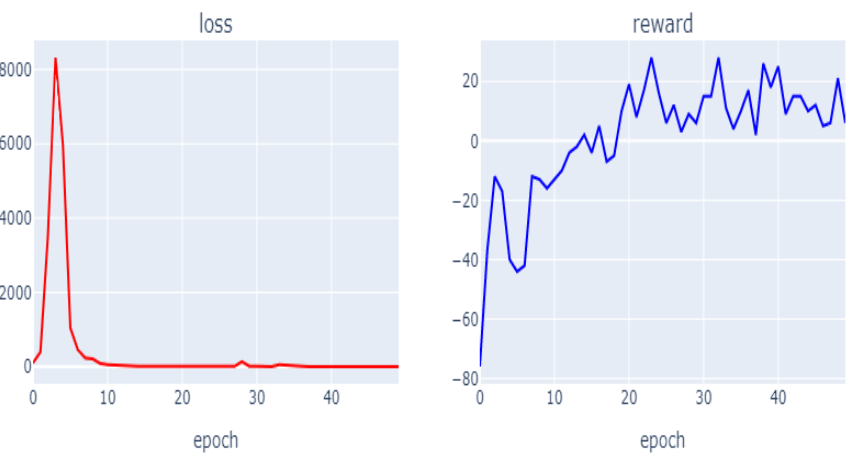
Figure 7. Learning results by substituting the Dueling DQN algorithm based on the proposed Total Resource on Google.